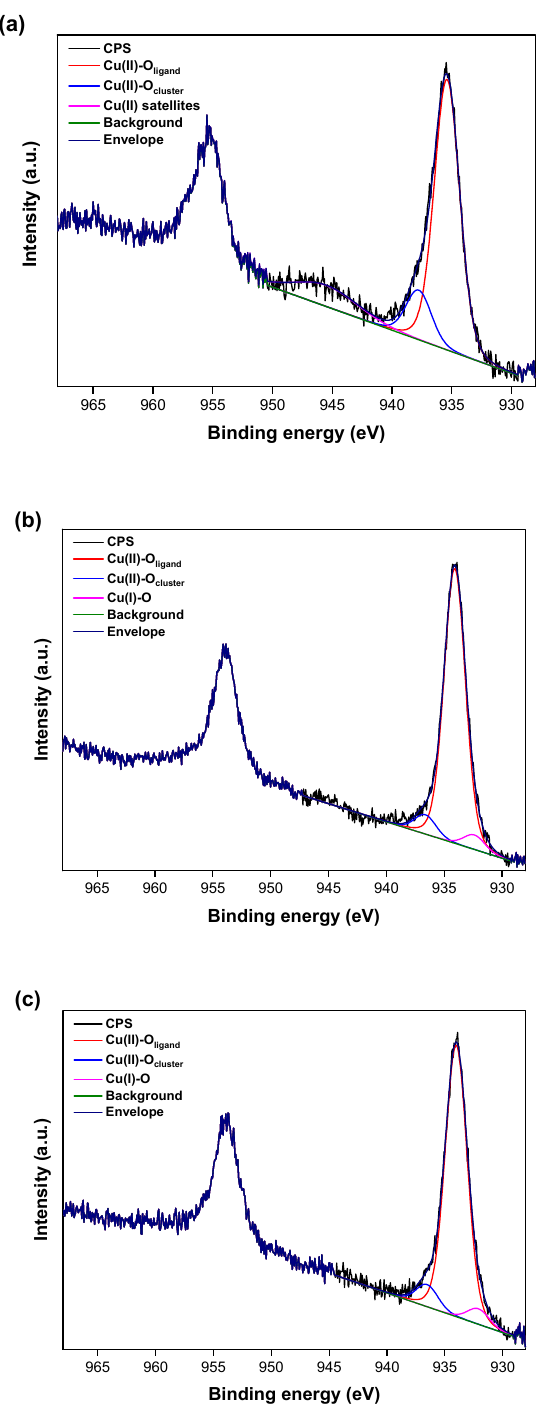
Figure 8. The high-resolution XPS spectra for Cu 2p of Eu@Cu-MOF before ( a ) and after 5 min ( b ) and 30 min ( c ) of treatment with AA at a concentration equal to 1.00 × 10 − 2 M. The optical responses of MOFs to analytes have different backgrounds and can be divided into mechanisms based on the collapse of frameworks, photoelectron transfer,